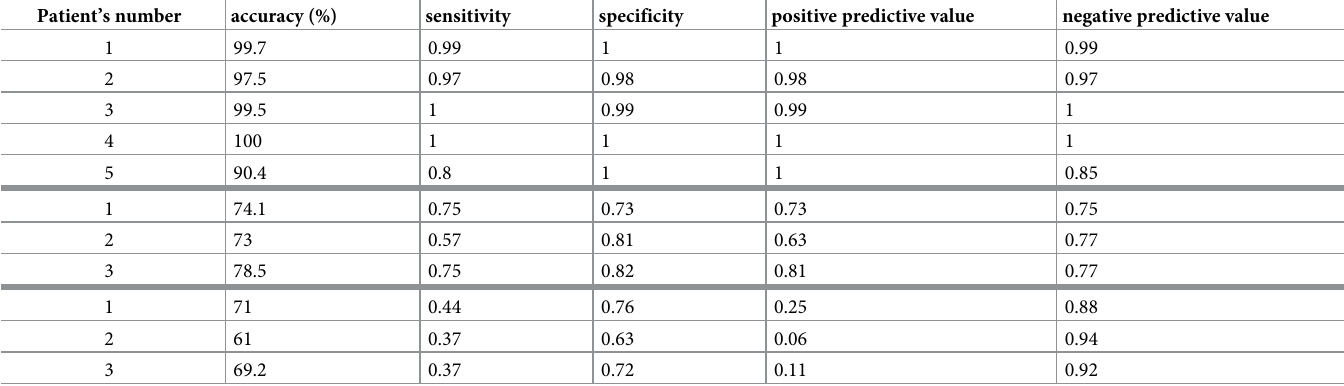
Predictions on the public Epilepsyecosystem dataset are lower than on the EPILEPSIAE data- set (around 70% for all patients; c.f. Fig 5 and Table 3). The lowest performance is for the patient 1 (74.1%) and the highest for the patient 3 (78.5%). Sensitivity, specificity, positive and negative predictive values for all patients are still higher than attainable results by a random classifier, but Table 3. Performance measures for all patients from the EPILEPSIAE dataset (upper section), from the Epilepsyecosystem public dataset (middle section) and Epi- lepsyecosystem benchmark dataset (lower section). Patient’s number accuracy (%)